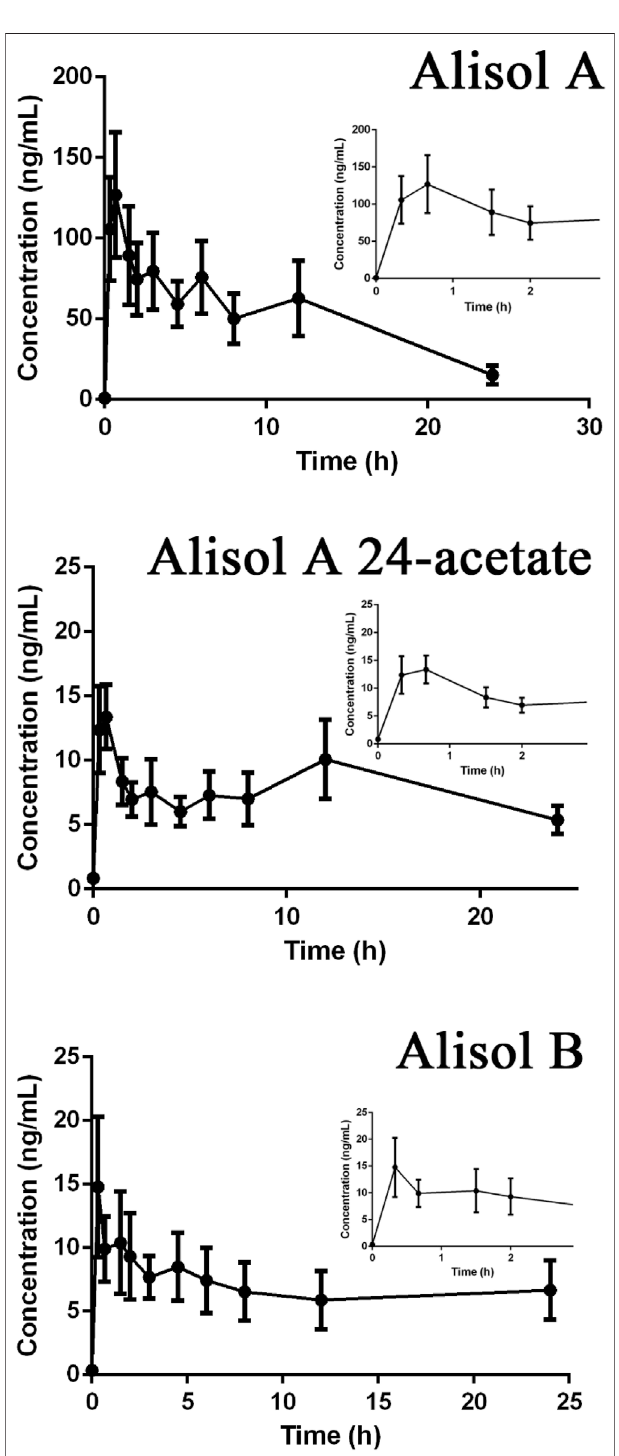
FIGURE 9 | The pharmacokinetic pro fi les of alisol A, alisol A 24-acetate, and alisol B.